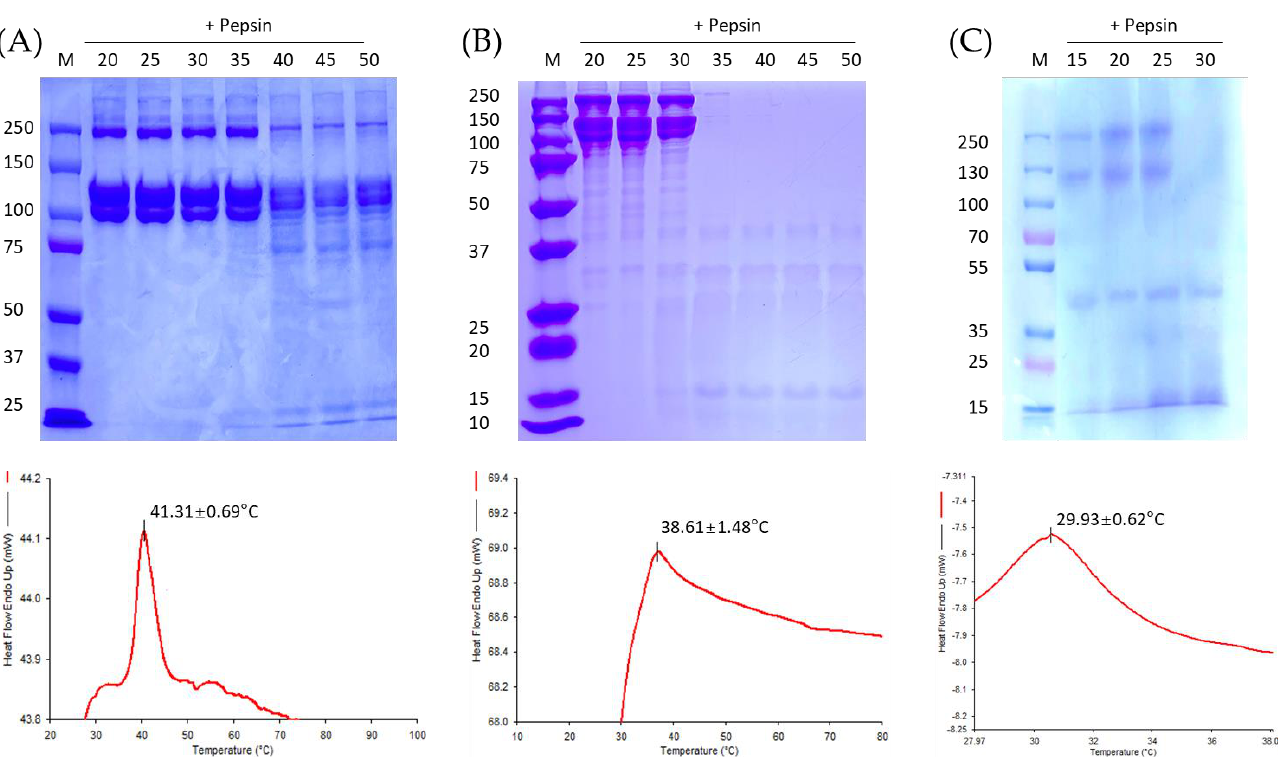
Figure 3. Thermal stability of collagen measured by enzyme digestion and DSC analysis. ( A ) porcine, ( B ) tilapia and ( C ) flatfish skin-based collagen.